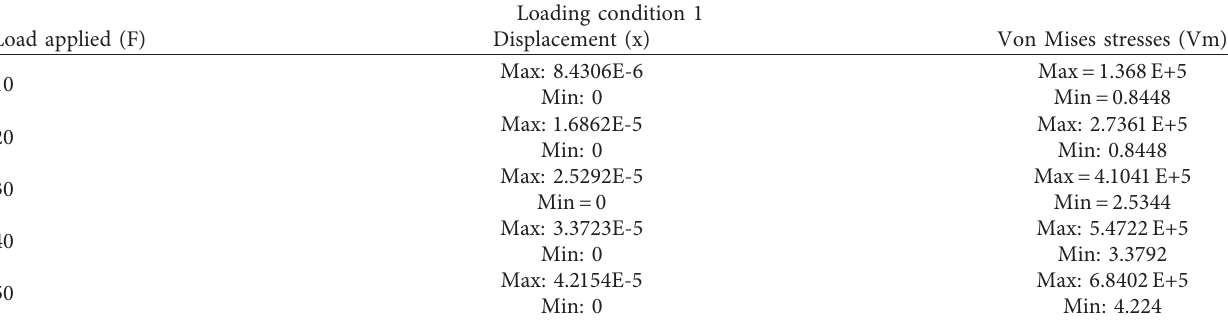
Table 1: Mechanical parameter combinations for loading condition